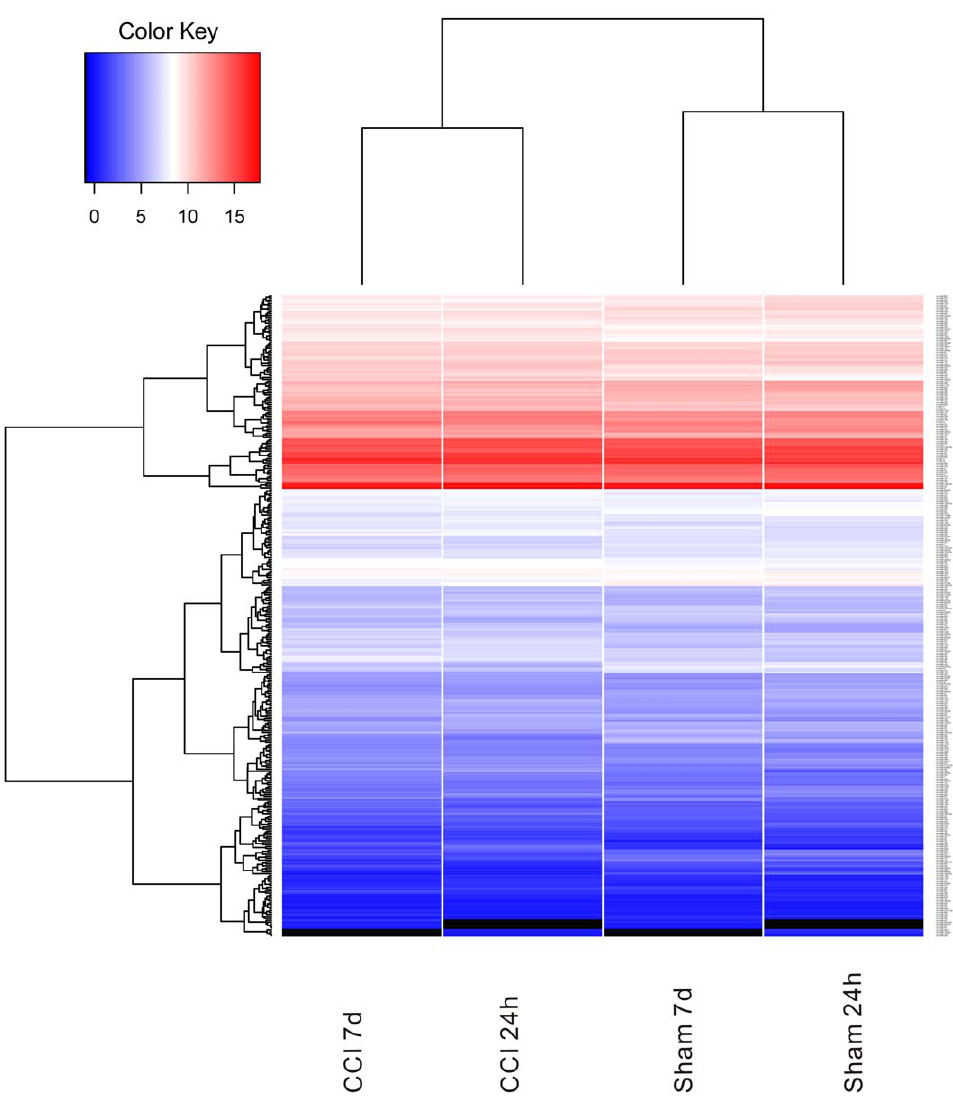
Figure 2. Heat map of miRNAs analyzed in the CCI brain. Heat map of mean signal intensities following normalization for all miRNAs detected in the CCI and sham control hippocampi by deep sequencing.